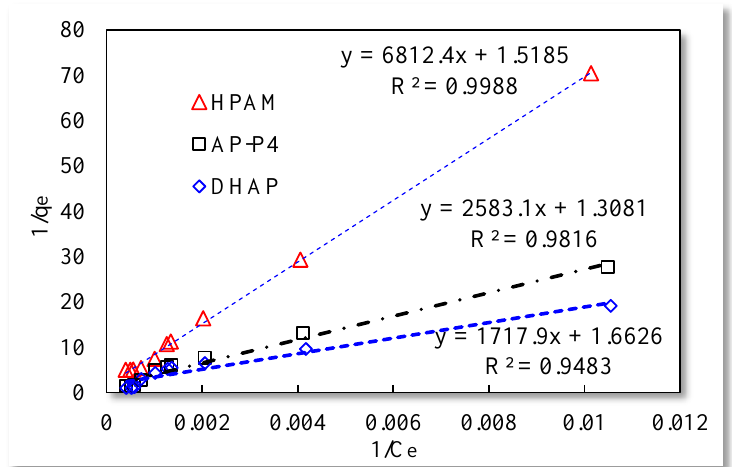
Figure 4. Langmuir isotherm adsorption model.